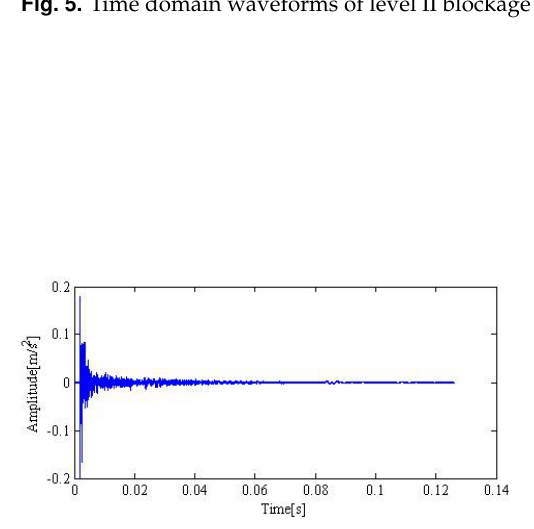
Fig. 5. Time domain waveforms of level II blockage